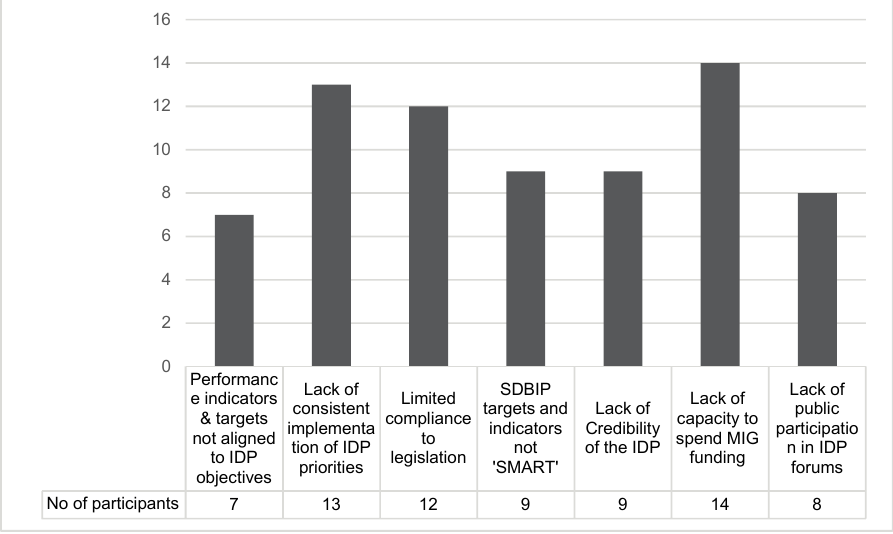
Figure 2: The role of councillors in the achievement of predetermined